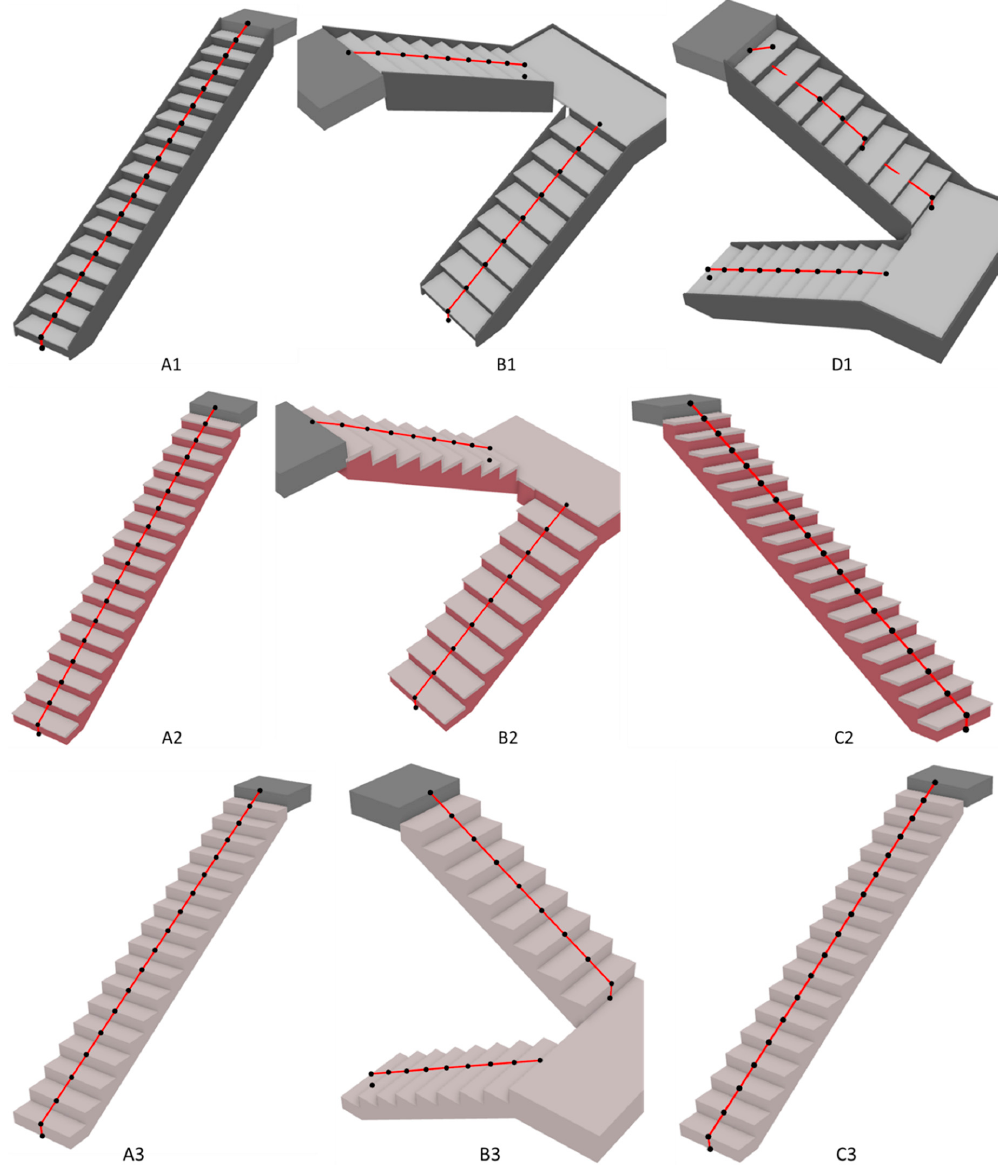
Figure 18. The test results for Groups 1–3.